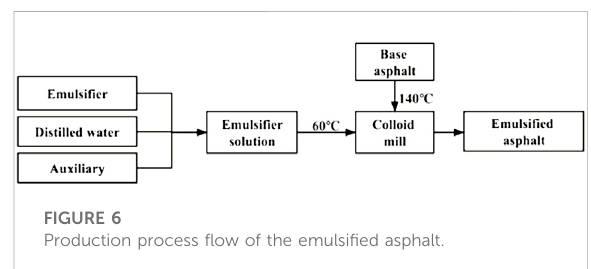
FIGURE 6 Production process fl ow of the emulsi fi ed asphalt.